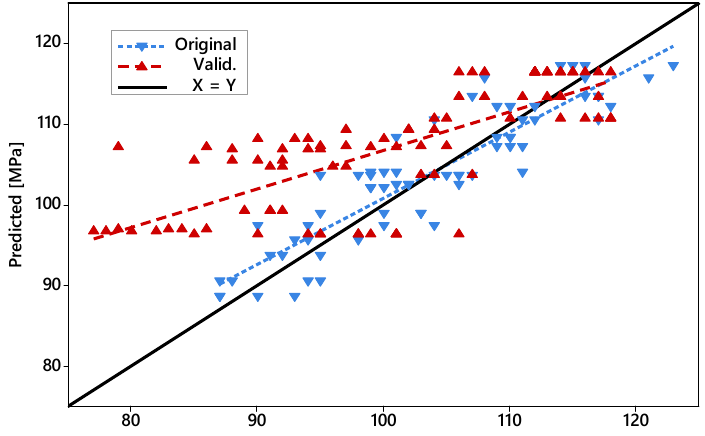
Figure 7. Scatterplot of predicted UTS (based on the DoE model) against the experimental UTS. “Original” denotes the points originally used to calculate the prediction model; “Valid.” denotes the validation points. Dashed lines were fitted based on each set.